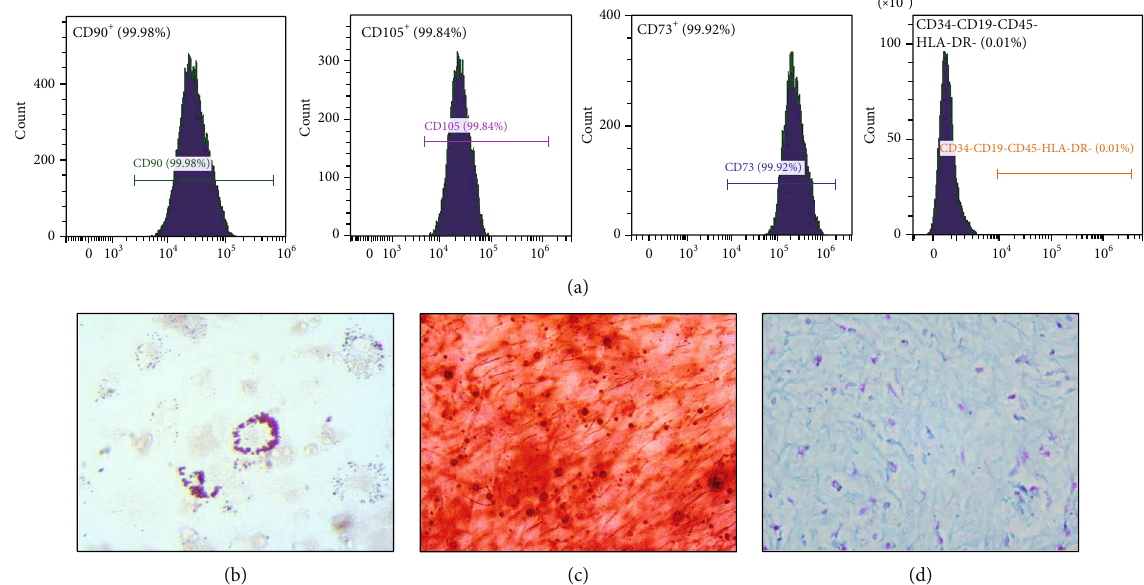
Figure 1: Identi fi cation of UC-MSCs. (a) Speci fi c surface markers of P5 UC-MSCs were examined by fl ow cytometry. (b – d) The potency of adipogenesis, osteogenesis, and chondrogenesis of P5 UC-MSCs was con fi rmed by Oil Red O, Alizarin Red, and Alcian Blue,